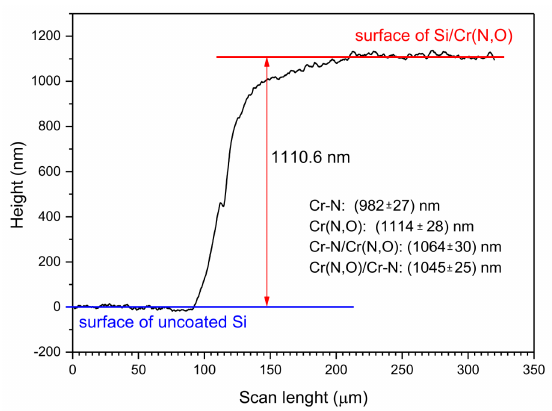
Figure 3. Thickness of the Cr(N,O) coating deposited on Si, measured by surface profilometry, according to the standard DD ENV1071-1:1994, along with all coatings’ thickness